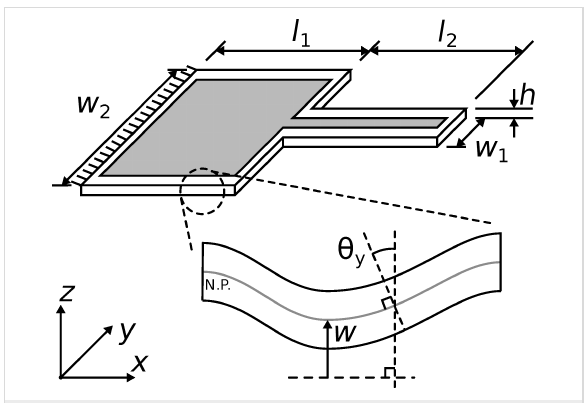
Figure 1: The dimensions of the basic cantilever design. The gray zone is the piezoelectric layer. The zoomed in section of a plate shows the out of plane deflection w and the rotation of the normal of the canti- lever’s neutral plane (N.P.) about the y -axis θ y . The rotation of the normal of the cantilever’s neutral plane about the x -axis θ x is equiva- lent to θ y for a section in the yz -plane. The fixed boundary of the canti- lever is shown to the left of the image.